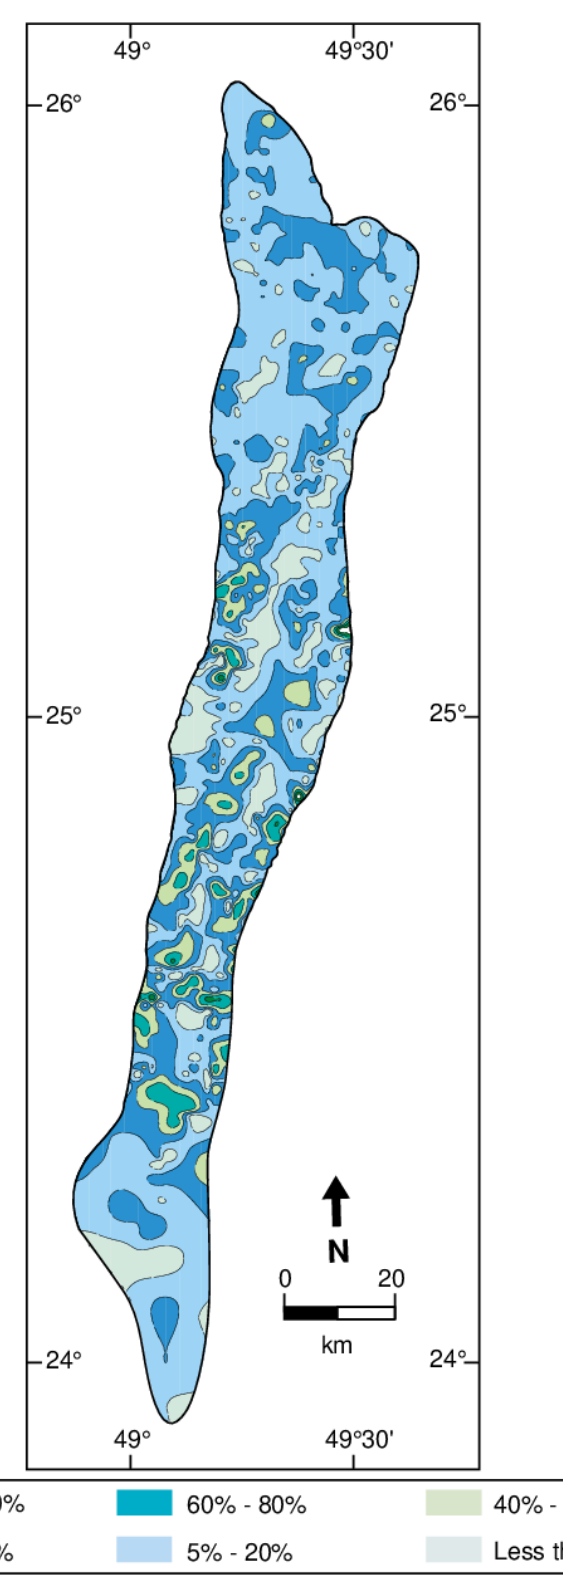
Figure 5. Dolomite content in the Arab-D section of the Ghawar oilfield (reprinted/adapted with permission from